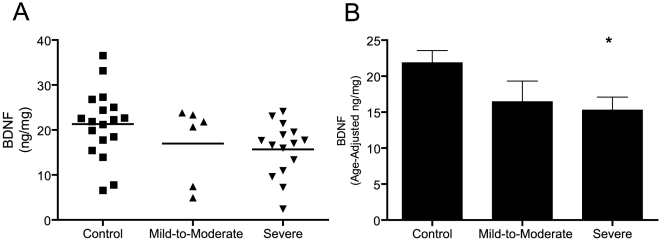
Plasma levels of BDNF in control and autistic patients.BDNF levels were quantified by ELISA in plasma samples from control and autistic patients. Absolute quantities were normalized against plasma protein concentrations. (A) Mean BDNF levels are significantly reduced in severely autistic patients compared to controls when adjusting age as a covariate and following post-hoc Sidak's adjustment for multiple comparisons. (B) Estimated marginal means for plasma BDNF levels were computed with the age covariate held at 86.18 months. The mean difference between control and severely autistic patients is enhanced when age is regressed (*p = 0.038). Thus, BDNF levels are decreased in the plasma of severely autistic patients relative to controls.